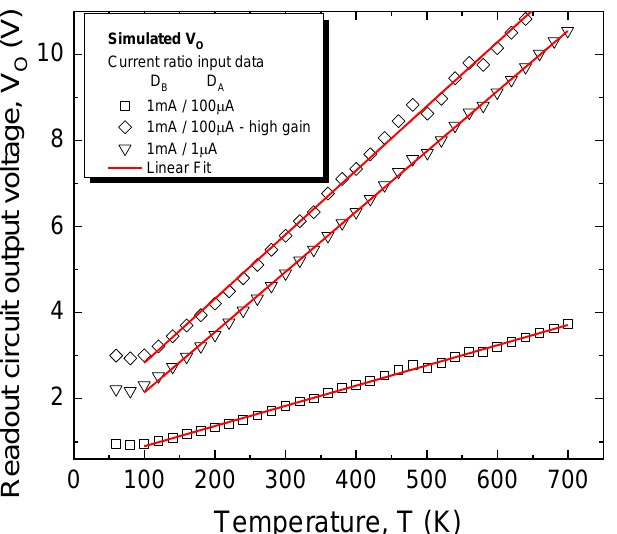
Figure 10. Sensitivity, coefficient of determination, and temperature error vs. diode current ratios for both differential configurations.